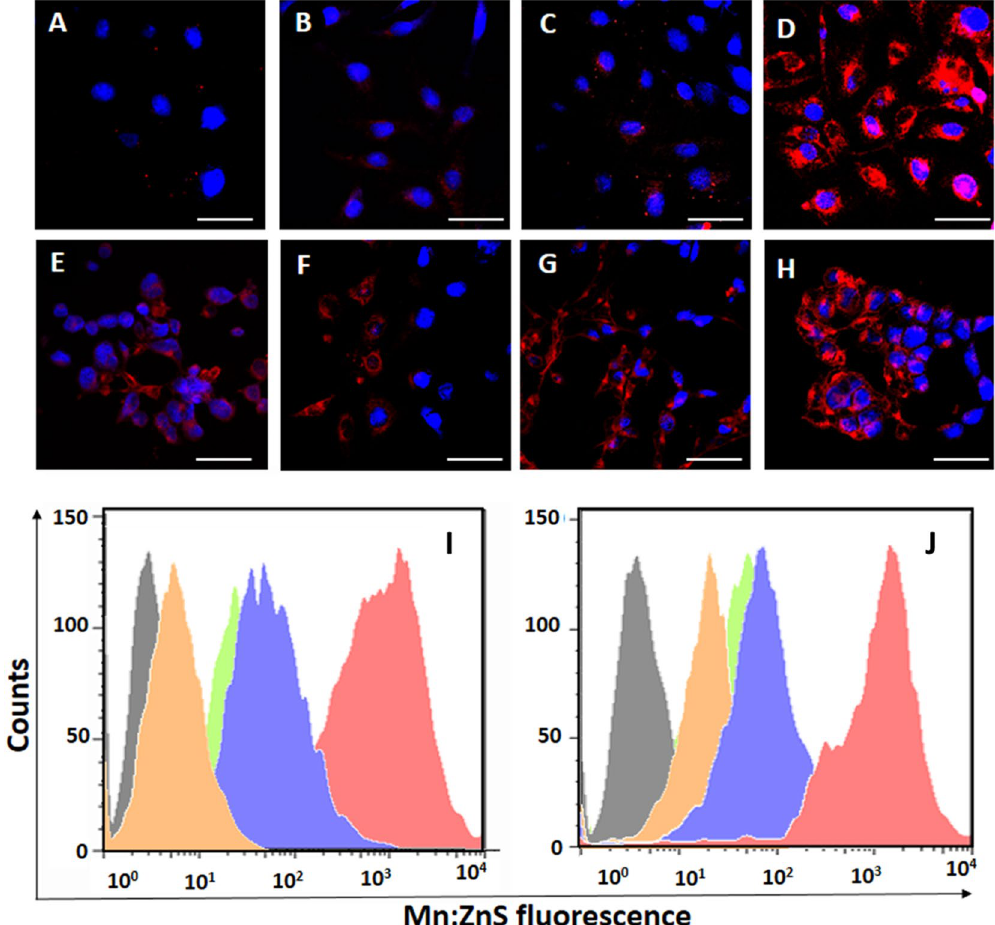
Figure 3. Confocal laser scanning electron microscopic images showing cellular localization pattern of CPP modified NPs: ( A ) Mn:ZnS NPs; ( B ) PEN:Mn:ZnS NPs; ( C ) pVEC:Mn:ZnS NPs; ( D ) R9:Mn: ZnS NPs in SKOV-3 after 24 h incubation period; ( E ) to ( H ) are the same experiments in HeLa cells; ( I ) to ( J ) are their flowcytometry based uptake of CPP modified NPs on SKOV-3 and HeLa cells, respectively, after a 24 incubation period; The gray histogram represents the control cells, orange histogram for control Mn:ZnS NPs; green histogram for PEN:Mn:ZnS NPs; blue histogram for pVEC:Mn:ZnS NPs; and red histogram for R9:Mn:ZnS NPs (Red emission indicates the fluorescence from Mn:ZnS NPs, and blue represents the DAPI nuclear stain’s florescence, scale bar 50 µ m; the bright reddish pink color indicates the co-localization of DAPI and Mn:ZnS